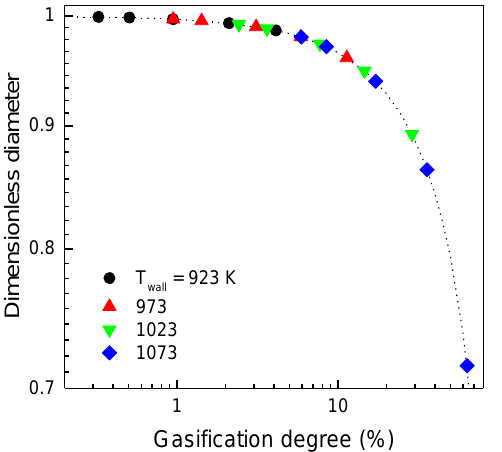
Figure 8. Dimensionless diameter decrease of the feed graphite particles flowing from the screw reactor.